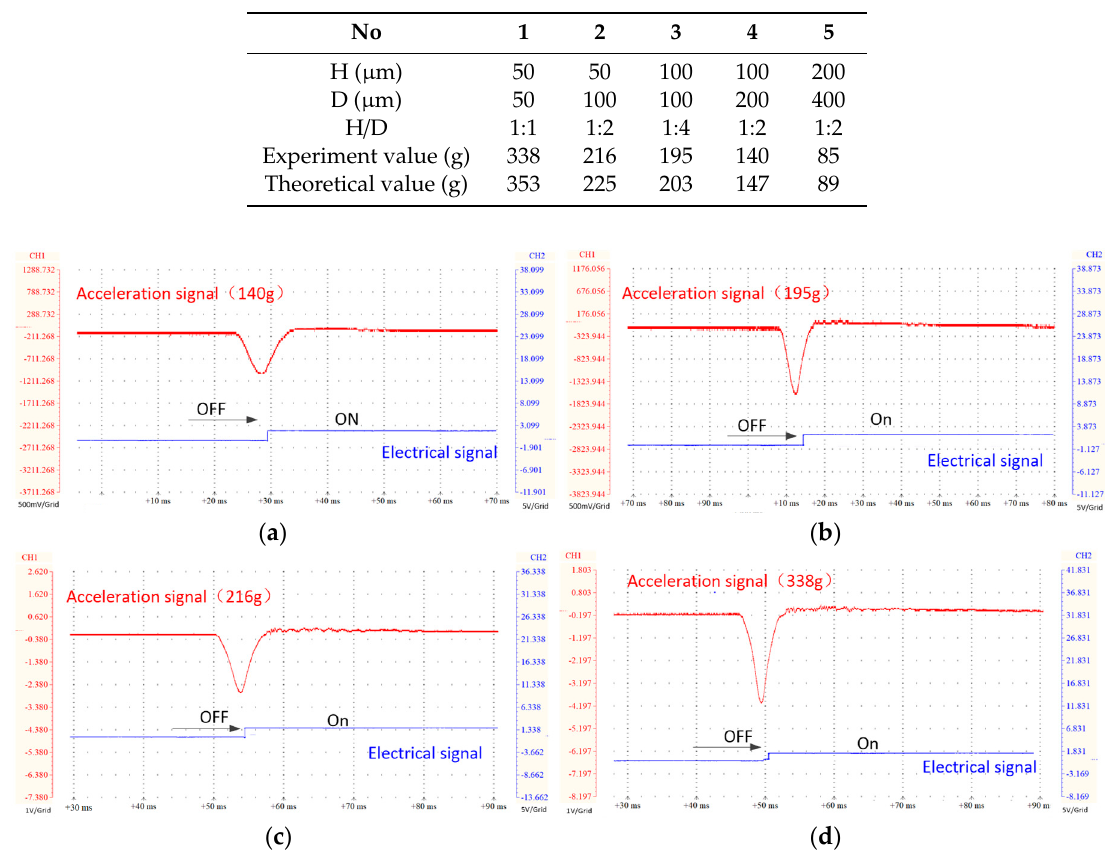
Figure 7. Experimental switching profile of actuation versus signal voltages. ( a ) under load of 140 g; ( b ) under load of 195 g; ( c ) under load of 216 g; ( d ) under load of 338 g.